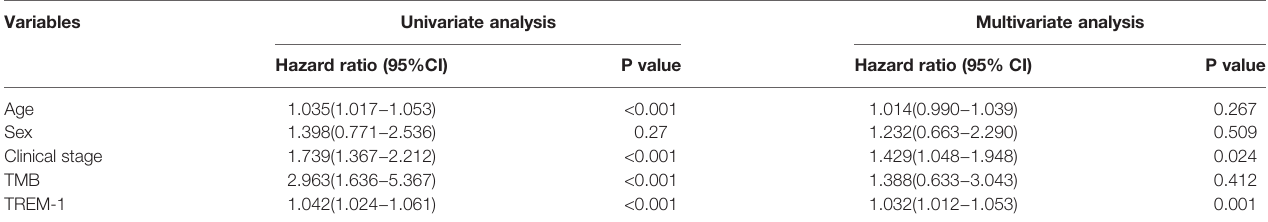
Relationship of TREM-1 Expression With Clinical Parameters The PTC patients in TCGA cohort were separated into two groups according to TREM-1 expression level (H-TREM-1 and